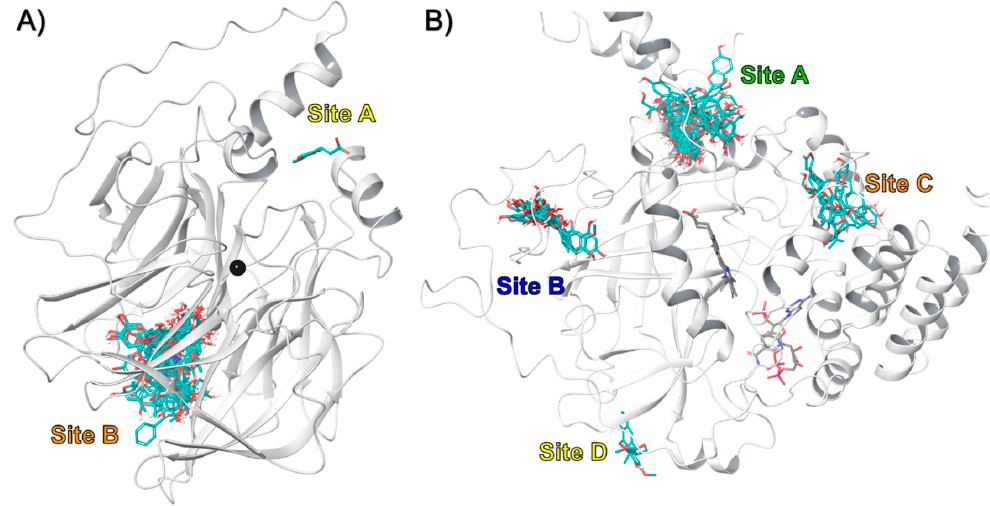
Figure 3. Binding of all compounds in ( A ) rPON1 and ( B ) rCAT in bind docking protocol.